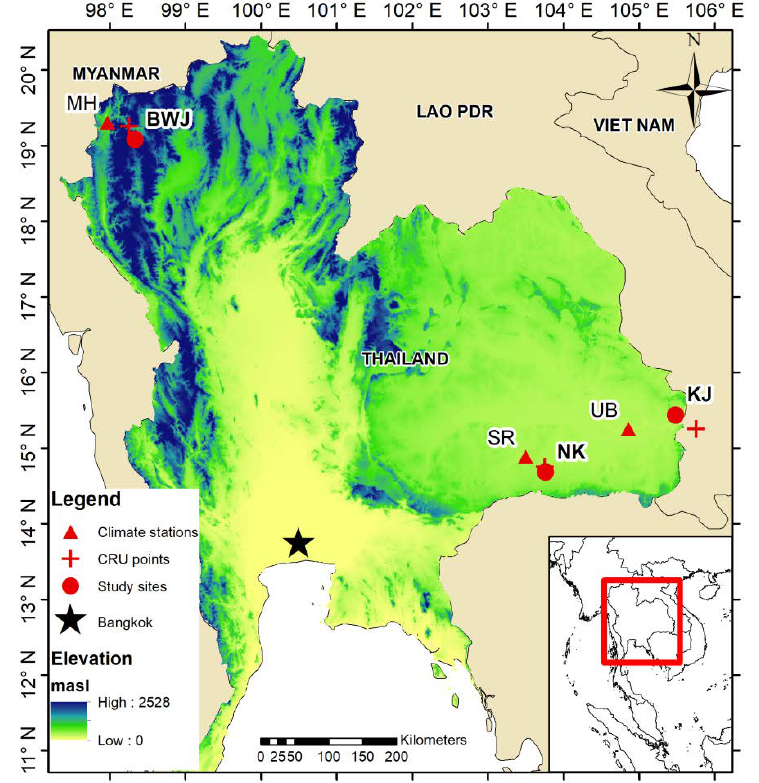
Figure 1. Map showing sampling sites of P. latteri (circles) at Ban Watchan (BWJ), Khong Jiam (KJ) and Nong Koo (NK), climate stations (triangles) and climatic research unit (CRU) grid points (crosses) in northwest and northeast Thailand.